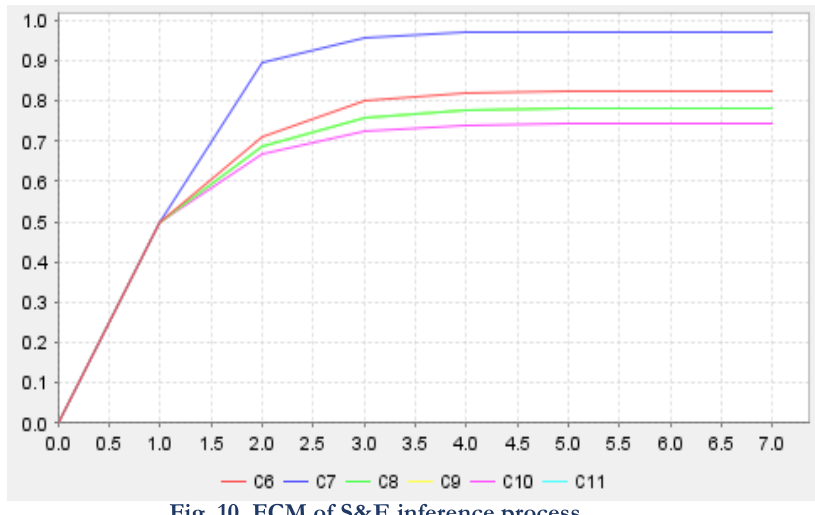
Fig. 10. FCM of S&E inference process.